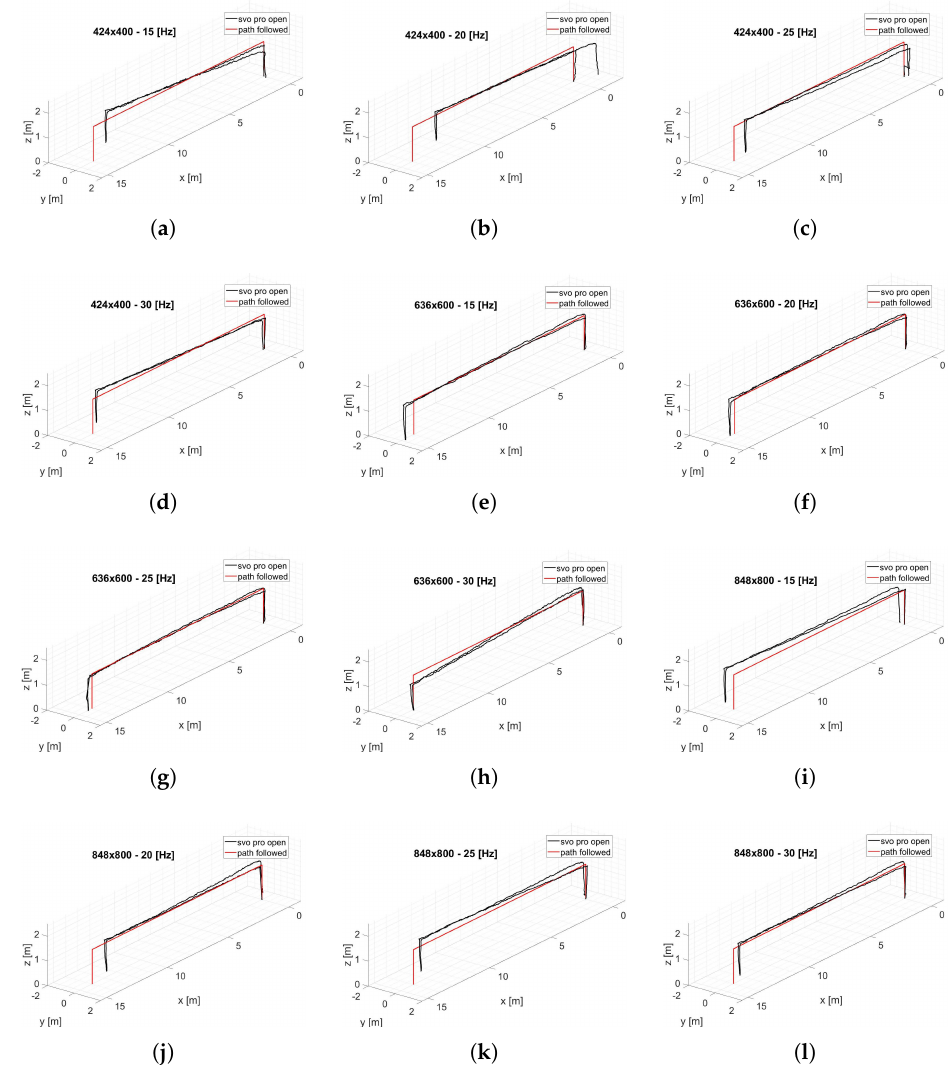
Figure 12. ( a ) 424 × 400, 15 Hz; ( b ) 424 × 400, 20 Hz; ( c ) 424 × 400, 25 Hz; ( d ) 424 × 400, 30 Hz;